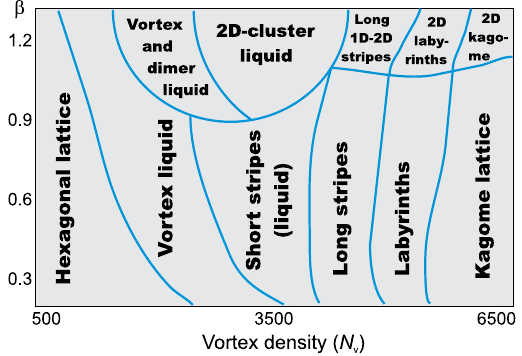
Fig. 1. A diagram showing the various morphologies of the vortex patterns that are encountered when varying the intervortex attraction force strength (cid:6) and the vortex density N v . For more details and a morphology diagram in the plane \pinning strength f p (cid:1)(cid:1)(cid:1) vortex density N v , see Ref. (i) a hexagonal vortex lattice, (ii) a liquid of vortex dimers, (iii) short stripes, (iv) long stripes, (v) interconnected stripes and labyrinths, and (vi) kagom (cid:2)e lattices